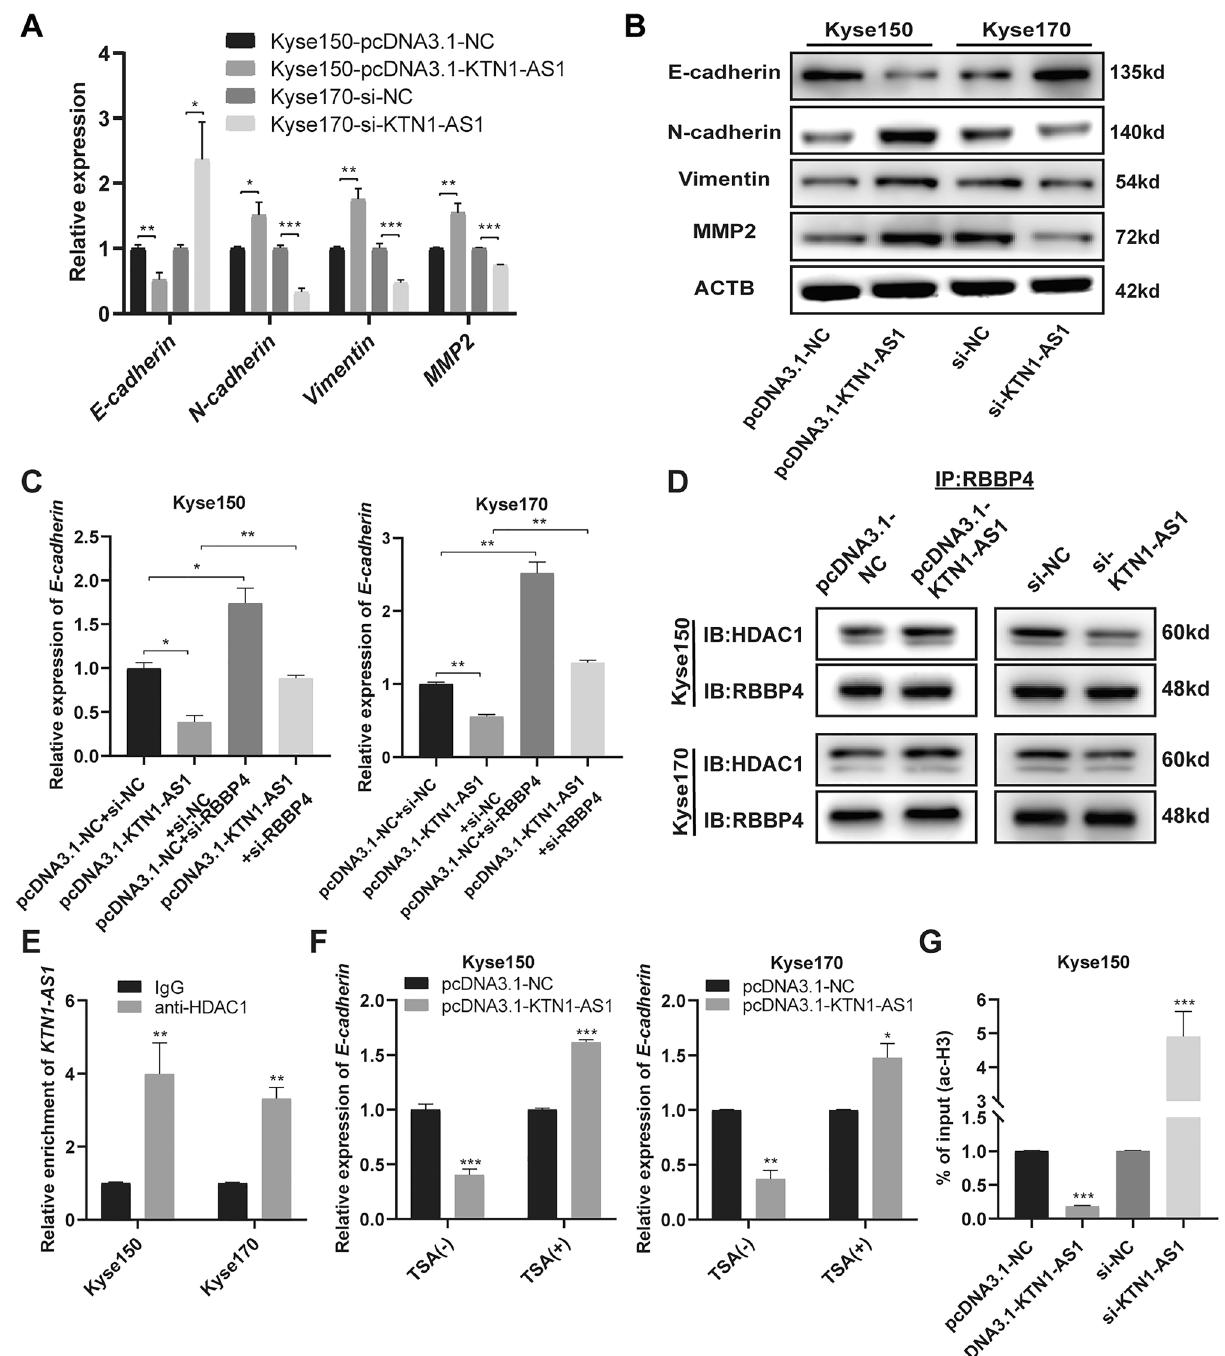
Figure 5. KTN1-AS1 relates to epithelial-to-mesenchymal transition (EMT) process by interacting with RBBP4 and HDAC1 to silence E-cadherin expression. ( A ) The mRNA expression levels of E-cadherin , N-cadherin , Vimentin , and MMP2 after KTN1-AS1 overexpression and knockdown. ( B ) The regulatory effect of KTN1-AS1 on protein levels of E-cadherin, N-cadherin, Vimentin, and MMP2 was detected by western blot. Original western blots were presented in Supplementary Fig. S5D, with blots cut prior to hybridization with antibodies. ( C ) Inhibition of RBBP4 increased the expression level of E-cadherin and partially reversed the regulation effect of KTN1-AS1 on the expression level of E-cadherin in Kyse150 and Kyse170 cells. ( D ) Co-IP assay was performed to examine the RBBP4-HDAC1 interaction in the groups with KTN1-AS1 overexpression and inhibition in Kyse150 and Kyse170 cells. Original western blots were presented in Supplementary Fig. S5E, with blots cut prior to hybridization with antibodies. ( E ) RIP assay showed the interaction between KTN1-AS1 and HDAC1 in Kyse150 and Kyse170 cells. ( F ) After transfection of pcDNA3.1-NC or pcDNA3.1-KTN1-AS1 for 12–24 h in Kyse150 and Kyse170 cells, then cells with pcDNA3.1-KTN1-AS1 were treated with or without 300 nM Trichostatin A (TSA) for additional 48 h, the mRNA expression of E-cadherin was detected by qRT-PCR method. ( G ) ChIP- qPCR was performed to detect the enrichment of ac-H3 in the promoter region of E-cadherin after overexpression and knockdown of KTN1-AS1 in Kyse150 cells. Error bars are shown as mean ± SD from three replicate experiments (n = 3) (* P < 0.05, ** P < 0.01, *** P <